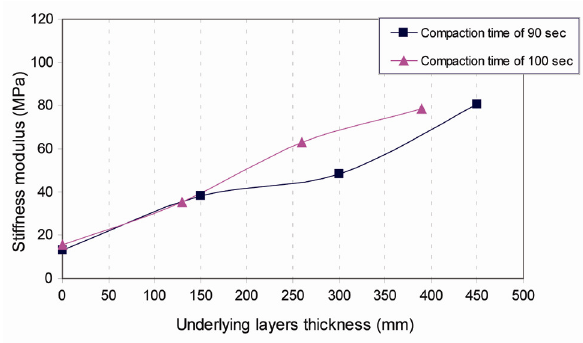
Fig. 10. Relationship between PFWD stiffness modulus of the upper layer and the thickness of underlying